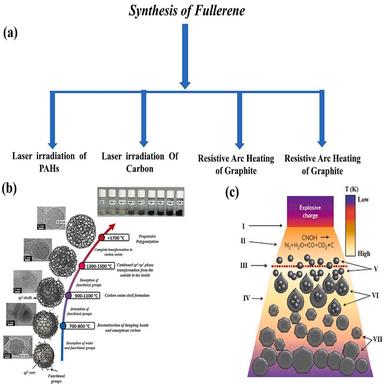
(a) Various methods adopted for the preparation of fullerene (b) The step-by-step annealing process with intermediates and their transmission electron micrographs for transforming the nanodiamonds into carbon onions. Reproduced with permission (c) A schematic representation of the propagation of the detonation wave used in the creation of nanodiamonds. Reproduced with permission.